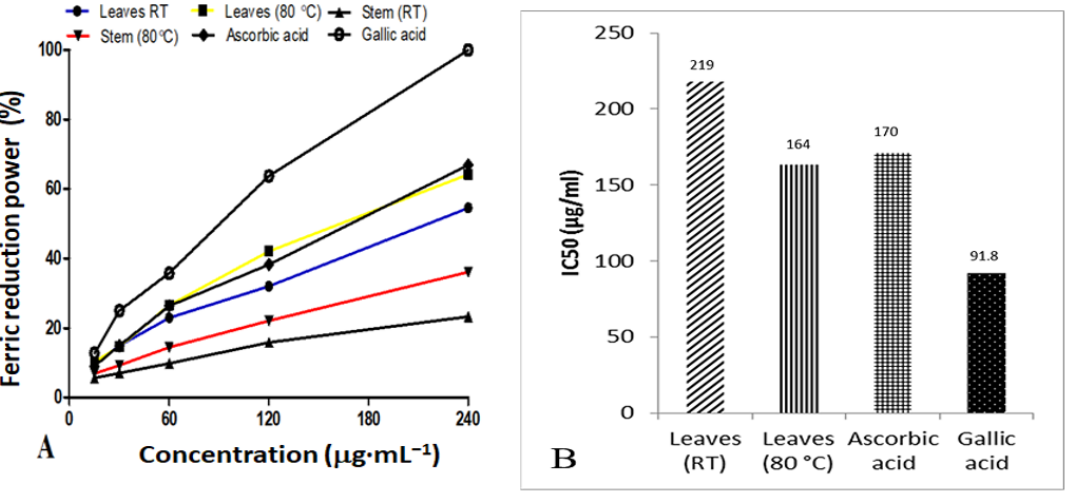
Figure 8. Comparison of percentage ferric reducing power ( A ) and the IC50 values ( B ) of D. villosa leaves AgNPs at room temperature (RT) and 80 °C.